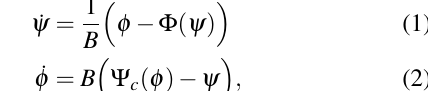
Figure 1: Schematic representation of a compressor in com- bination with a close-coupled valve, adopted from Gravdahl and Egeland (1997). Ψ c ( Φ ) and Ψ v ( Φ ) are the compressor pressure rise and valve pressure drop, respectively, and Φ is the axial mass flow